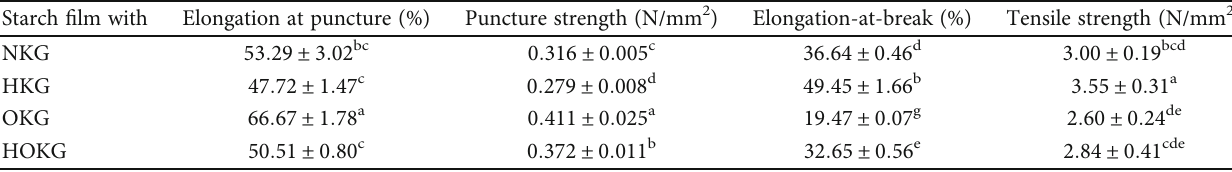
Table 2: Results of puncture and tensile tests of the fi lms.